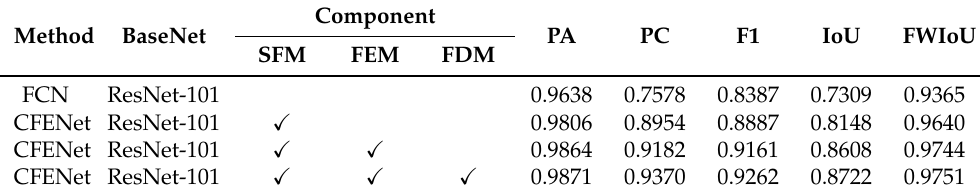
Table 3. Ablation study on WHU Building Dataset.